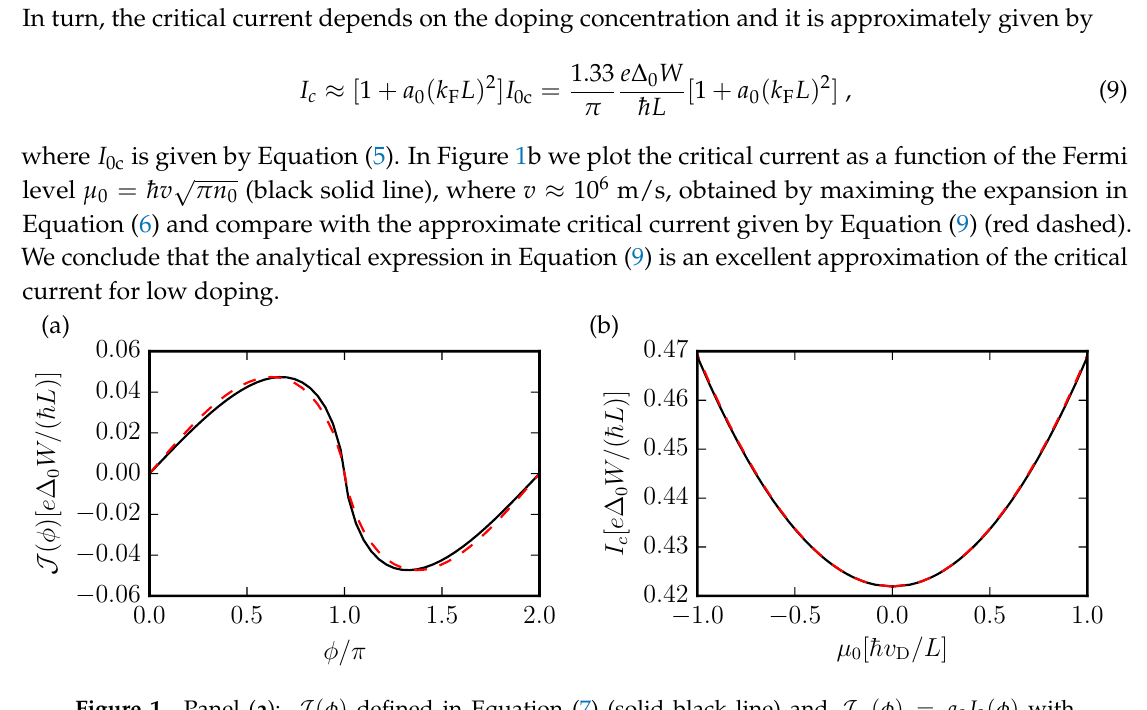
( φ ) = a ( φ ) with 0 I 0 J a 0